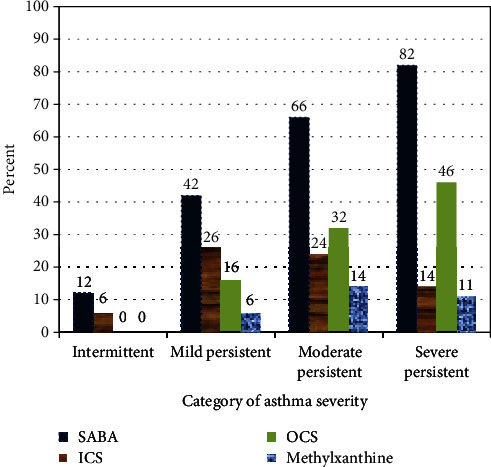
Medications prescribed after visit by type of asthma severity at Armed Forces Referral and Teaching Hospital, Addis Ababa, Ethiopia, July-October 2015 (n = 184).